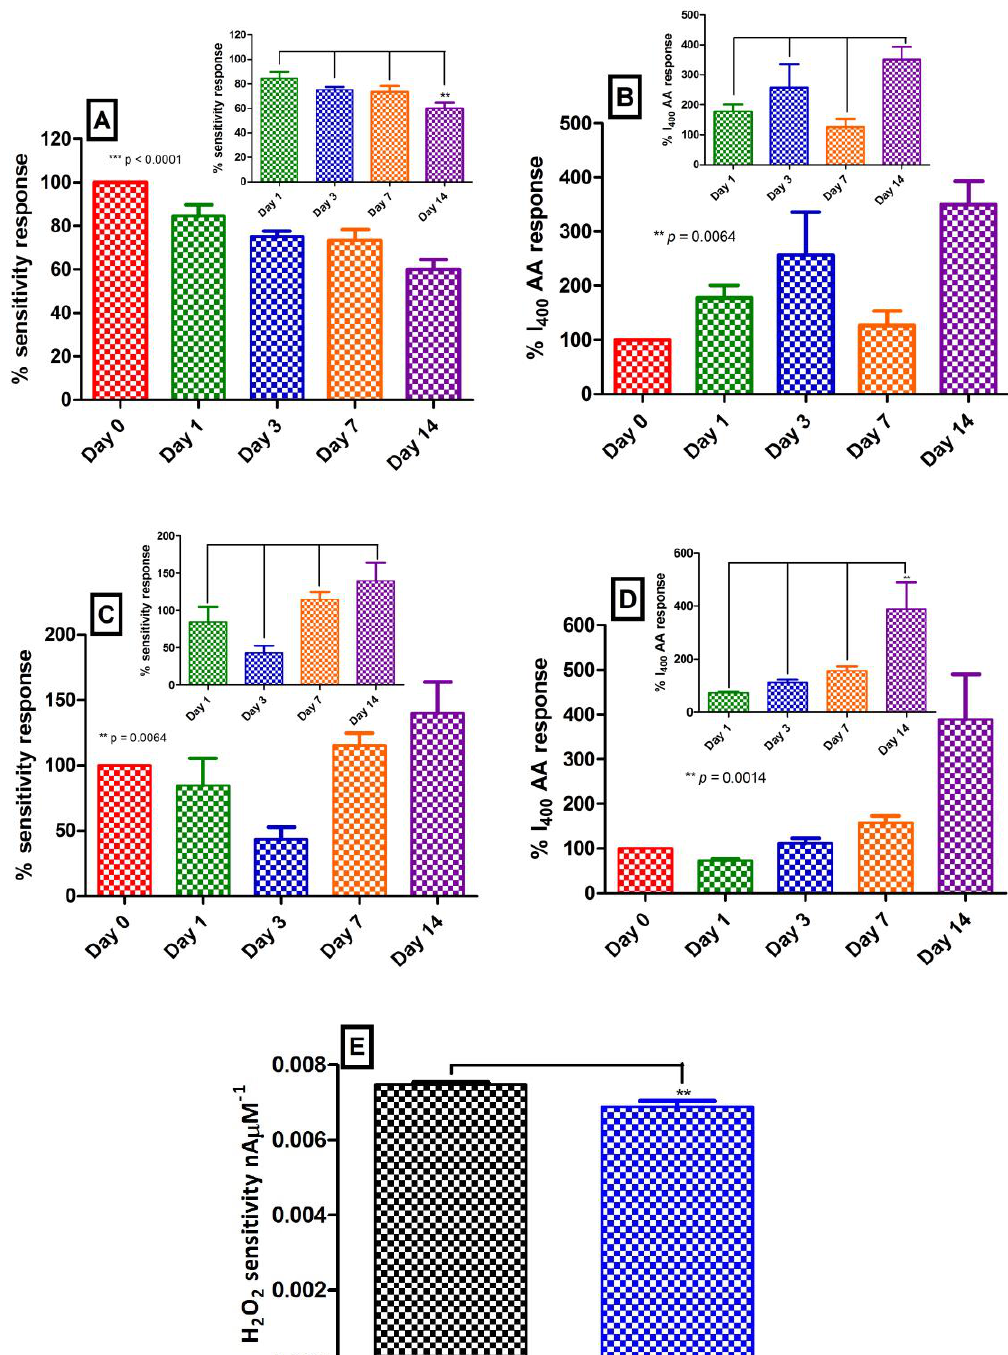
Figure 2. Ex vivo studies detailing effect of brain tissue (BT) exposure (0 – 14 day, n = 4) on: ( A ) H 2 O